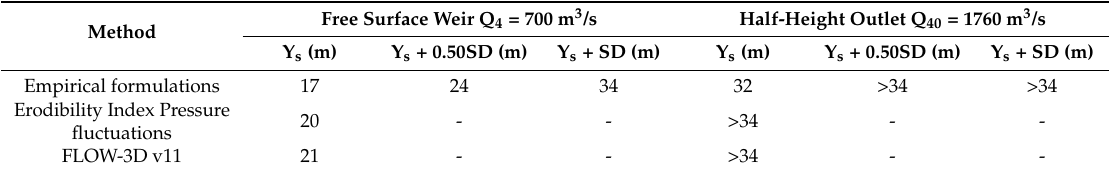
Table 9. Comparison of scour obtained by different methods for free surface weir and half-height outlet. Method